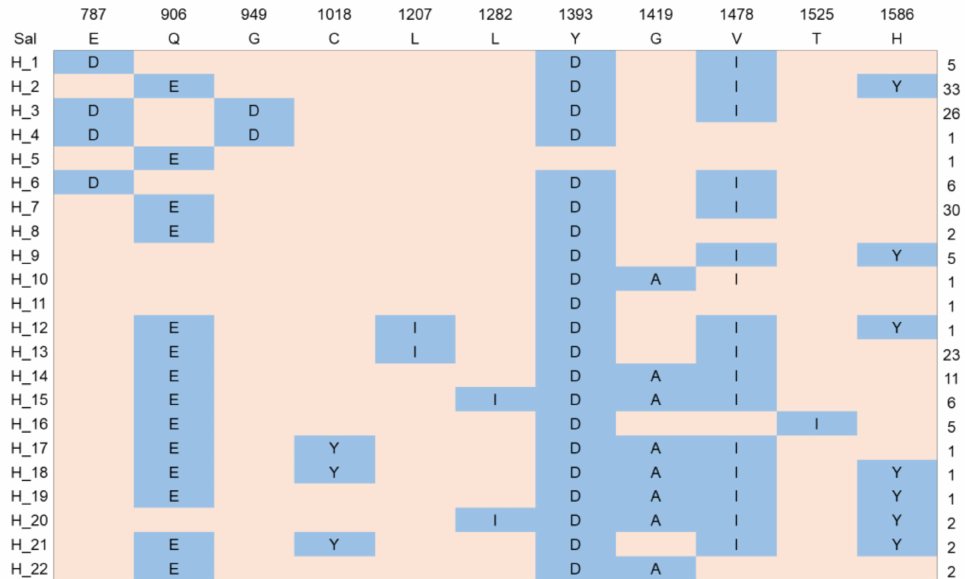
Figure 3. Amino acid alignment of the 22 pvmrp1 haplotypes in 166 isolates. Polymorphic amino acids are listed for each haplotype. Amino acid residues are identical to the reference sequence Sal -I marked in pink. The dimorphic amino acid changes are marked in blue. The total number of sequences for each haplotype is listed in the right